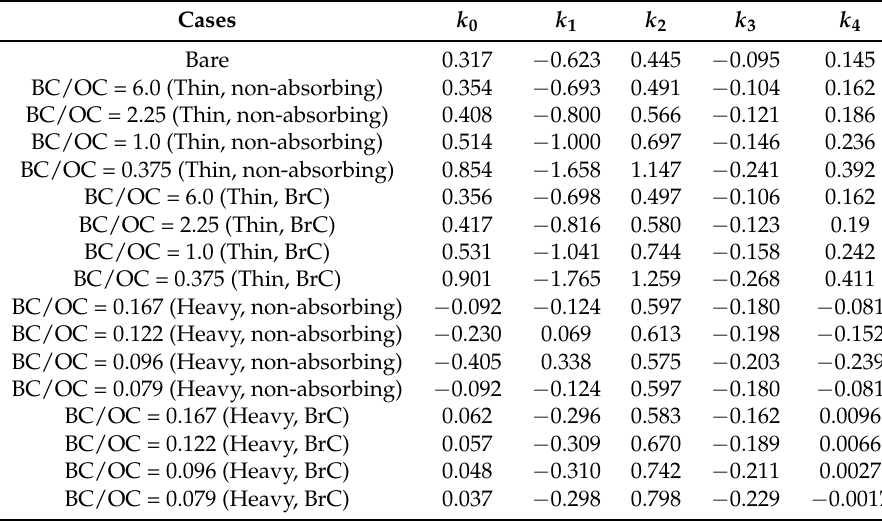
Table A5. Fitting parameters of BC aerosols for C ext (350 nm).